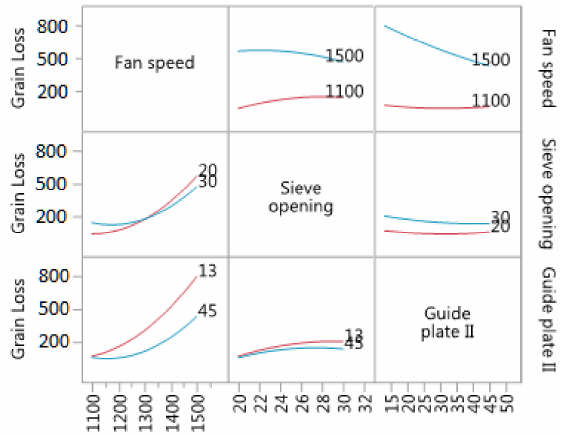
Figure 6. Interaction profiler for grain sieve loss.